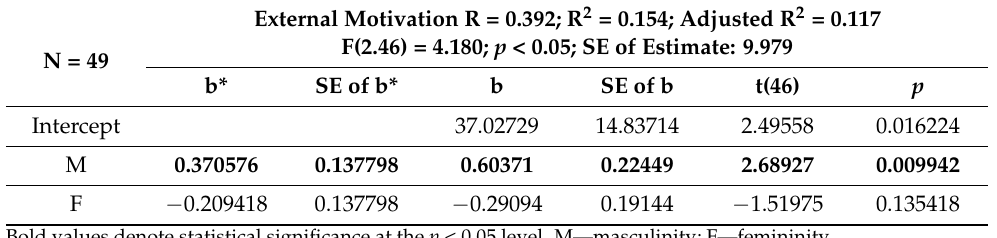
Table 4. Multiple regression explaining the variation in the presented level of extrinsic motivation based on psychological femininity and masculinity in the group of women studied.